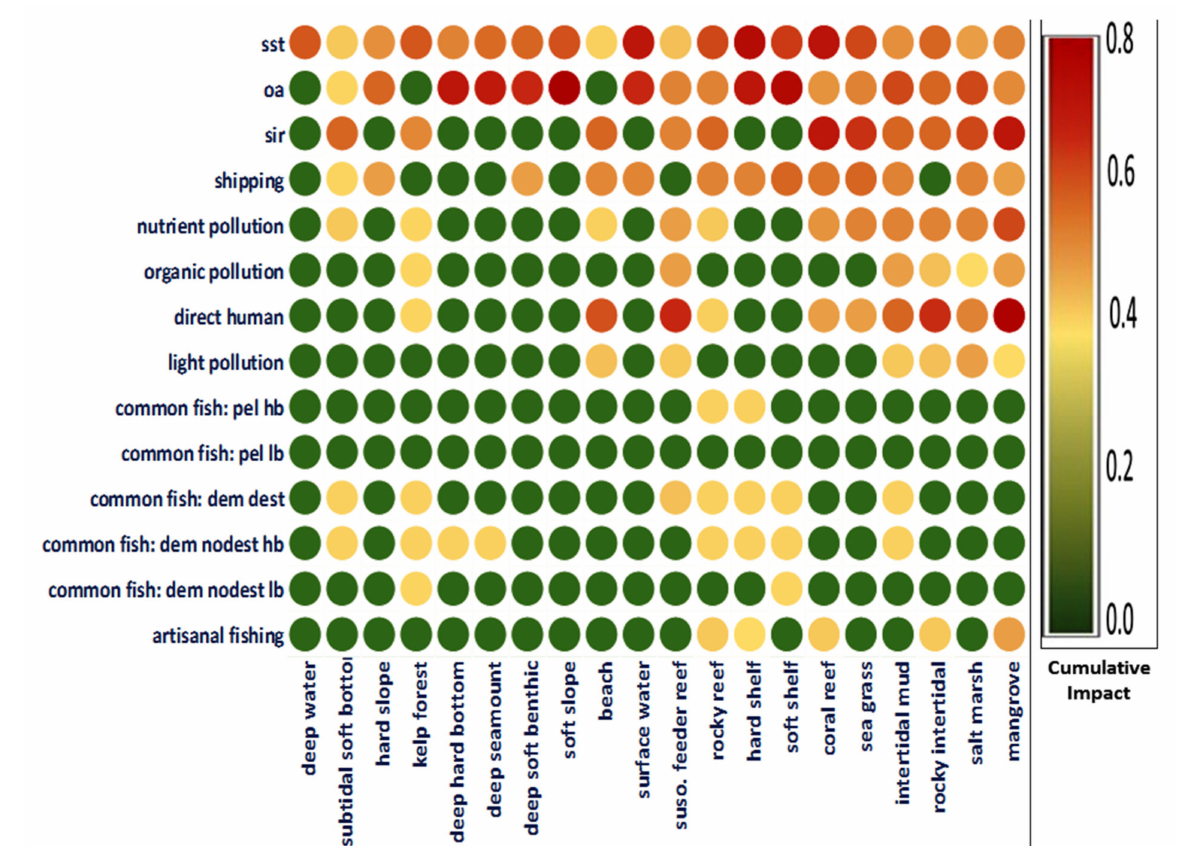
Figure 2. Influence of environmental salinity in different habitats. Salinity distribution and its cumulative impact on different aquatic animals—especially on fish and fisheries—are found to be highly relevant. Different zones, such as deep sea or mangrove habitats, have specific fish and fisheries values that are highly influenced by the salinity